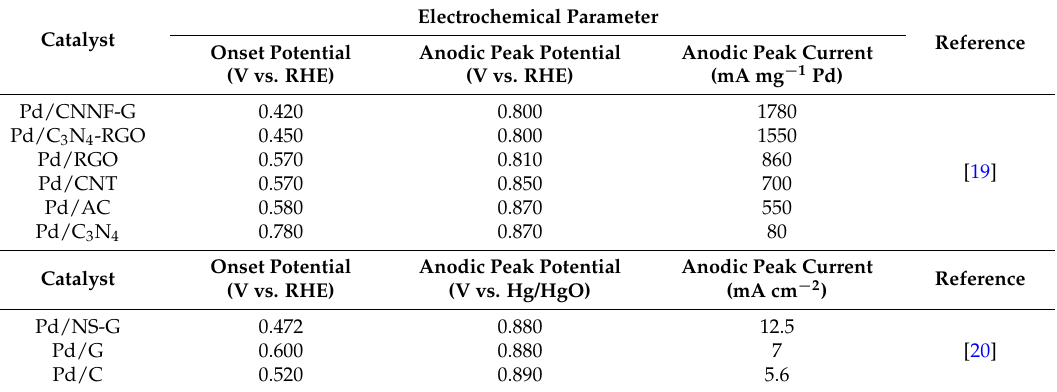
Table 1. Electrochemical properties of Pd catalysts supported on graphenes, doped graphenes, RGO, reduced graphene